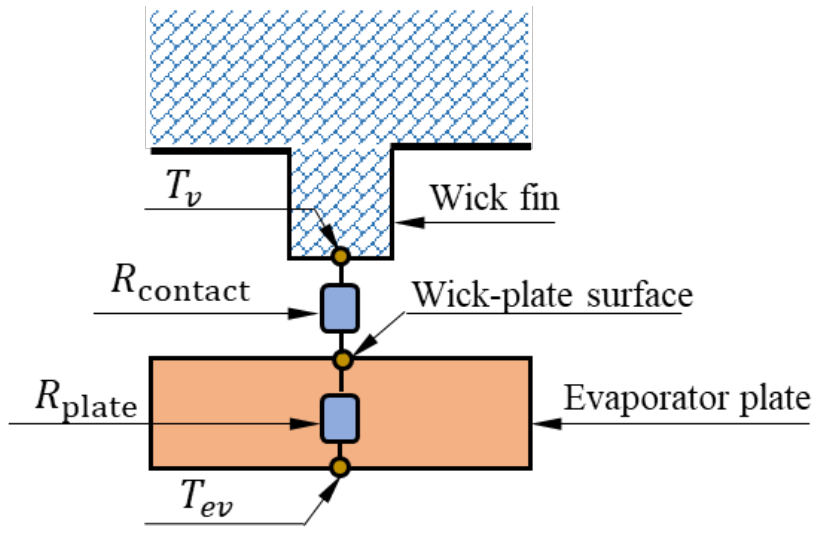
Figure 7. Schematic diagram of thermal resistance from wick fin to evaporator plate.